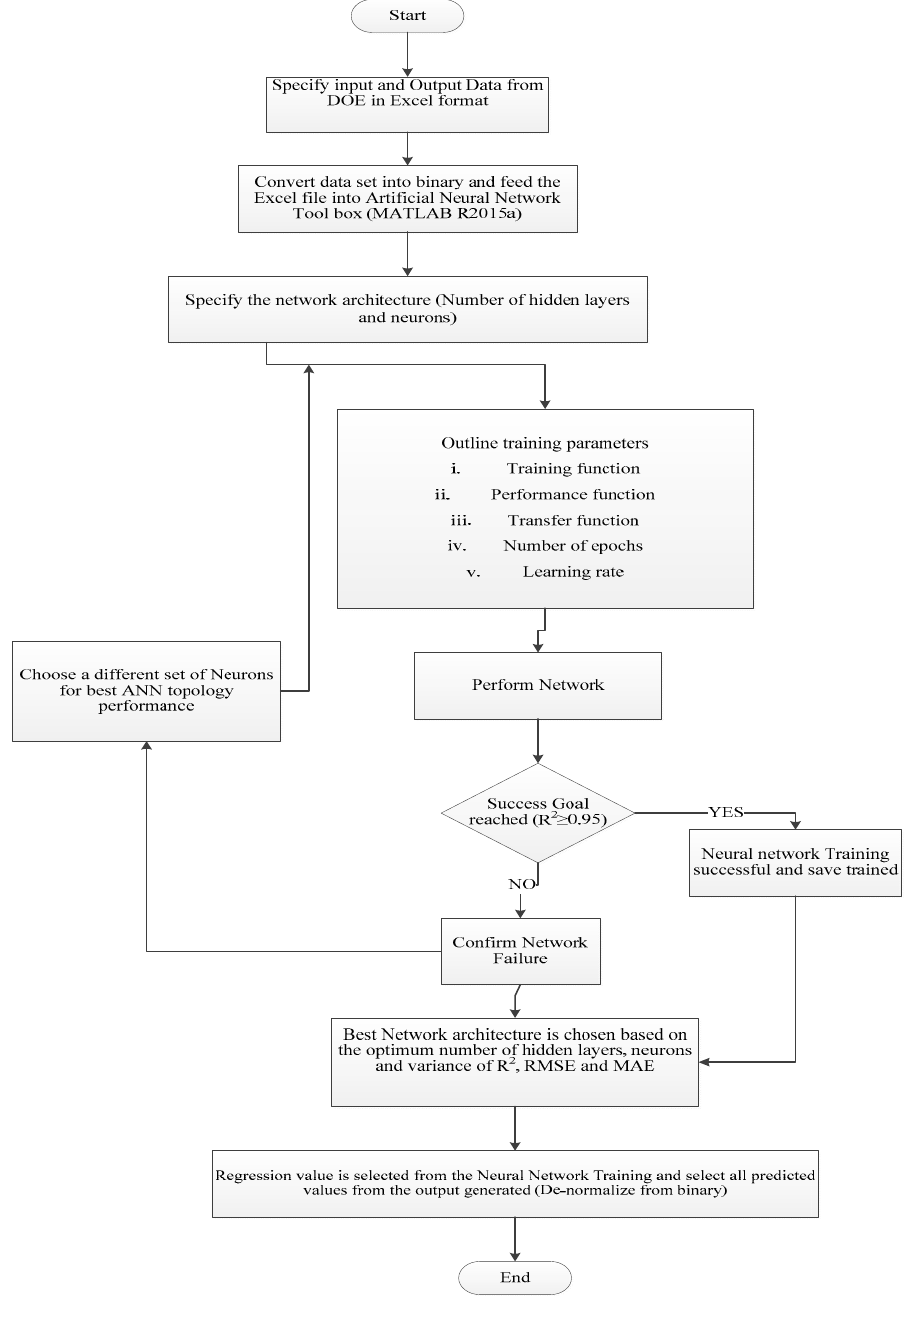
Figure 2. Artificial neural network model flow chart.